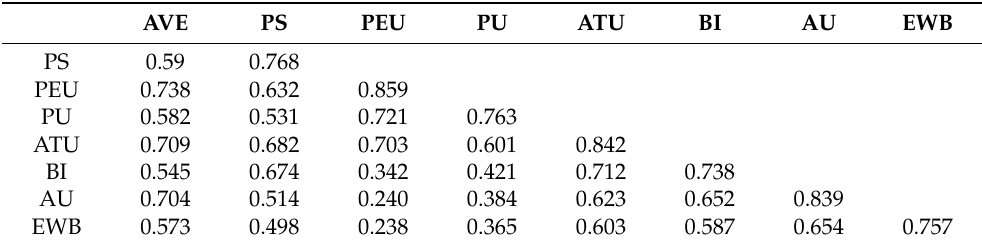
Table 3. Discriminant validity of the measurement